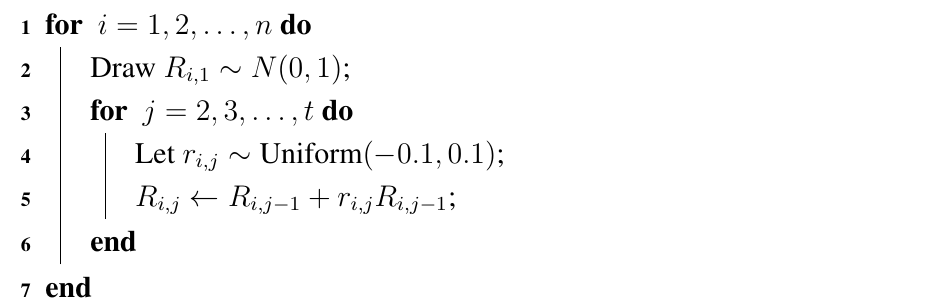
Algorithm 2: Synthetic Data Generating